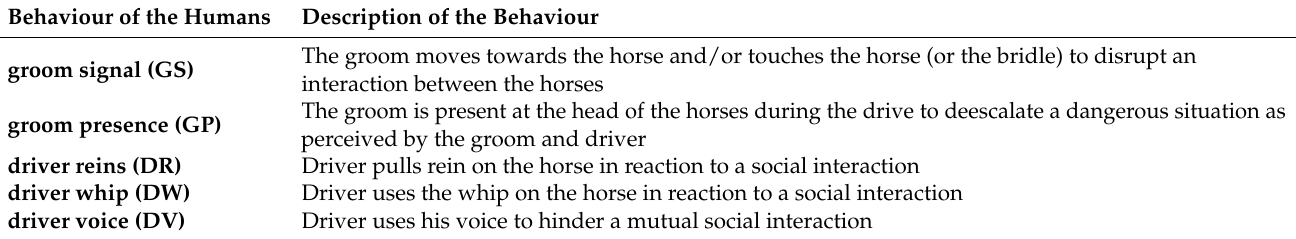
Table 2. Human interventions respective of the groom and driver reacting to social interactions between stallions, highlighted in bold, assessed during the drive test.